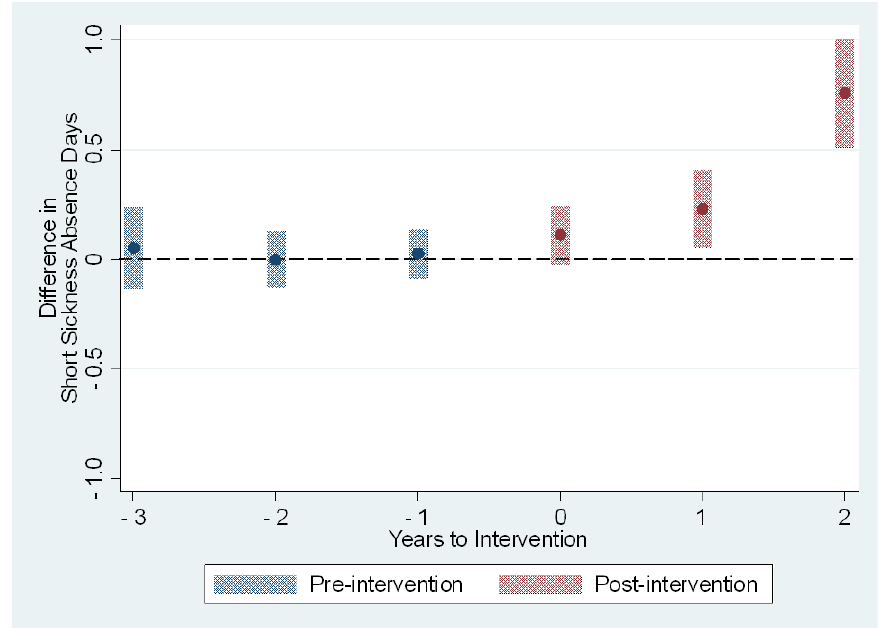
Figure 1. The estimated dynamic average treatment effects of the use of the participatory scheduling tool on sickness absence days from short absences of 1–3 days. Event study estimates with 95% confidence intervals depict difference in outcome measure between intervention and control groups relative to timing of the intervention. Year 0 is the first full year of the intervention.